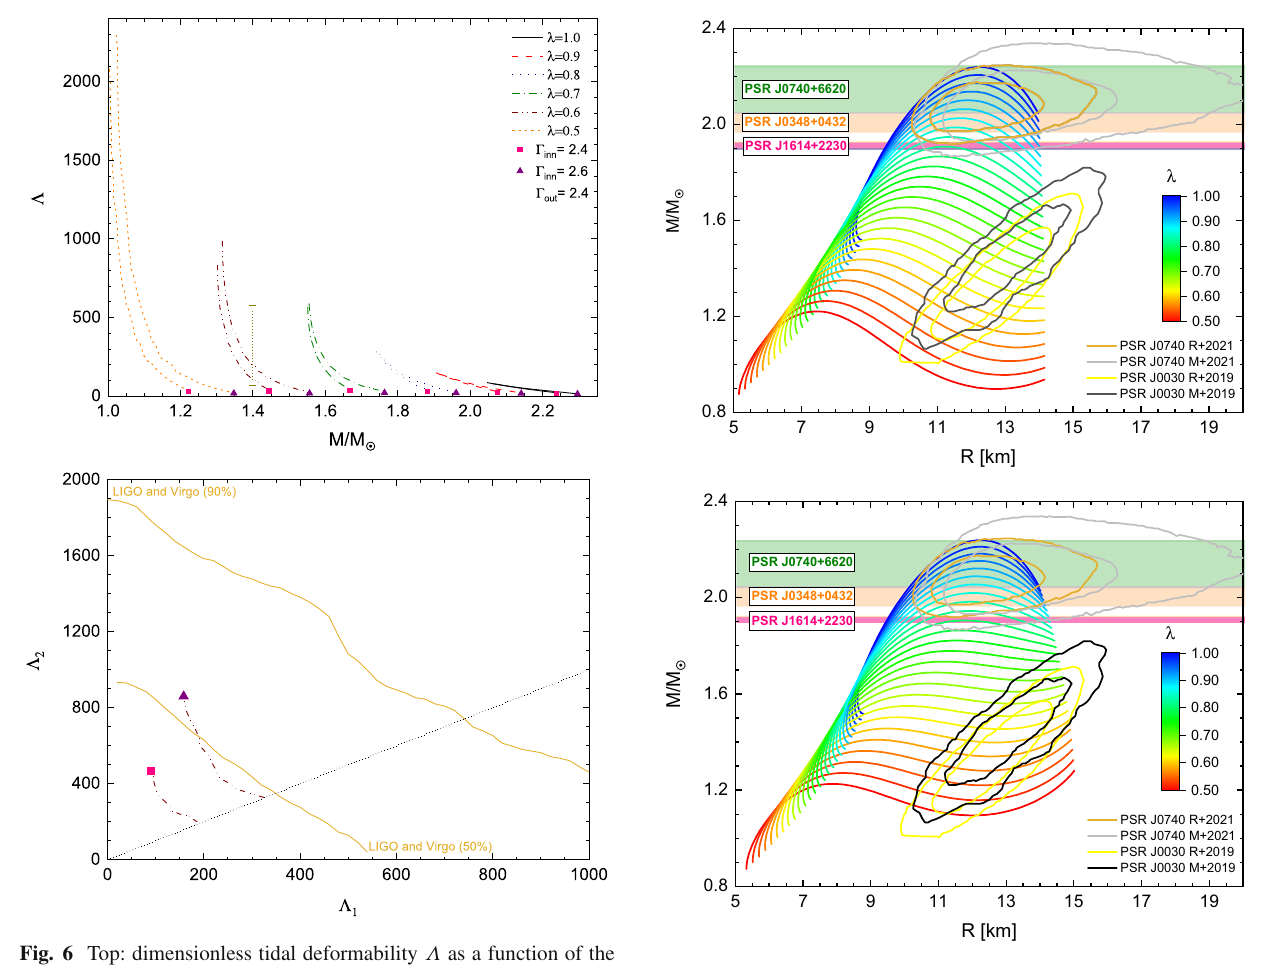
Fig. 7 Comparison of mass–radius curves with observational data using different values of λ , Γ inn = Γ out = 2 . 4 and two different values of ρ dis . On the top and bottom panel are respectively used inn ρ dis = 7 . 0 × 10 17 [ kg / m 3 ] and ρ dis = 9 . 0 × 10 17 [ kg / m 3 inn inn